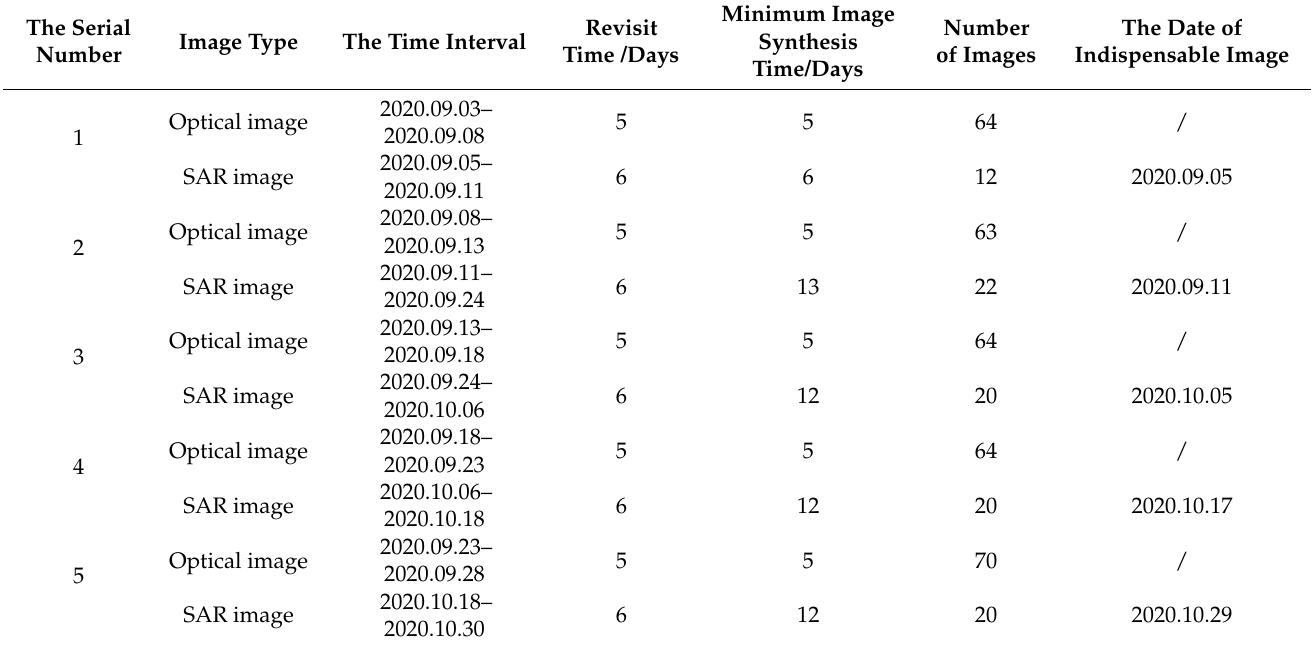
Table 5. Image synthesis table for the Changbai Mountain